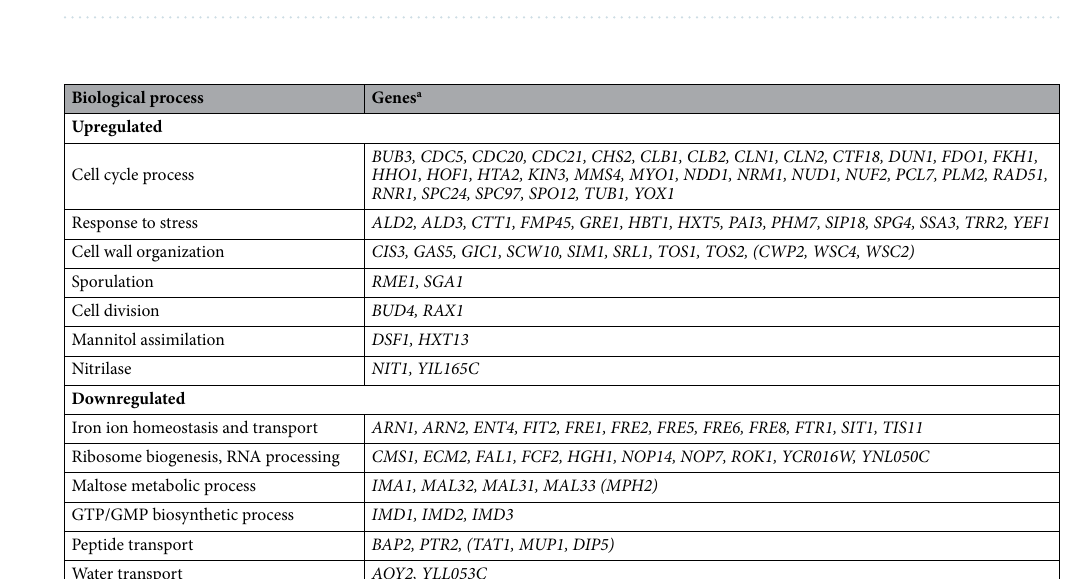
Table 4. Upregulated and downregulated biological processes in evolved S. cerevisiae F12 cells. a Multiple testing was analyzed by Holm-Bonferroni test correction.